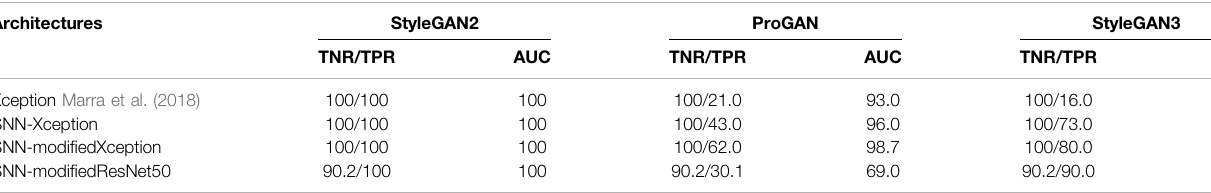
TABLE 6 | Performance comparison among different network